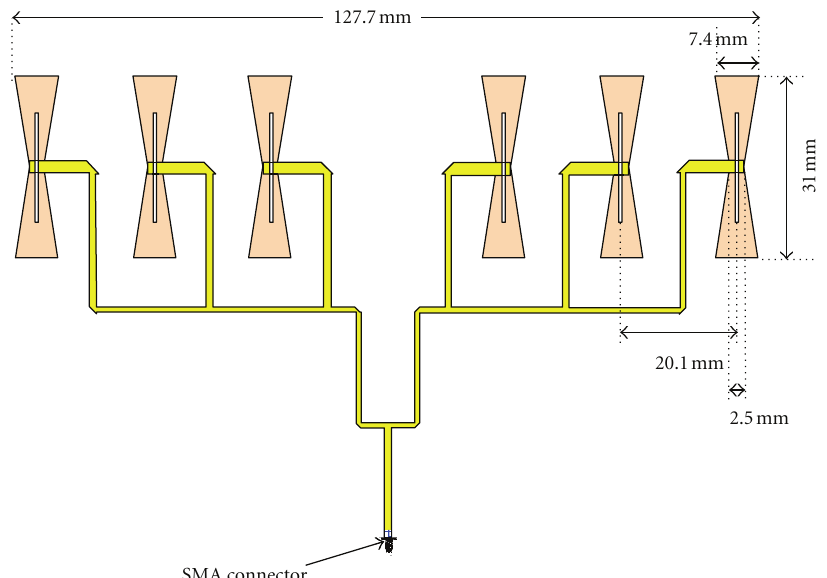
Figure 9: Mask of the multilayered bow-tie antenna array operating at the frequency 5